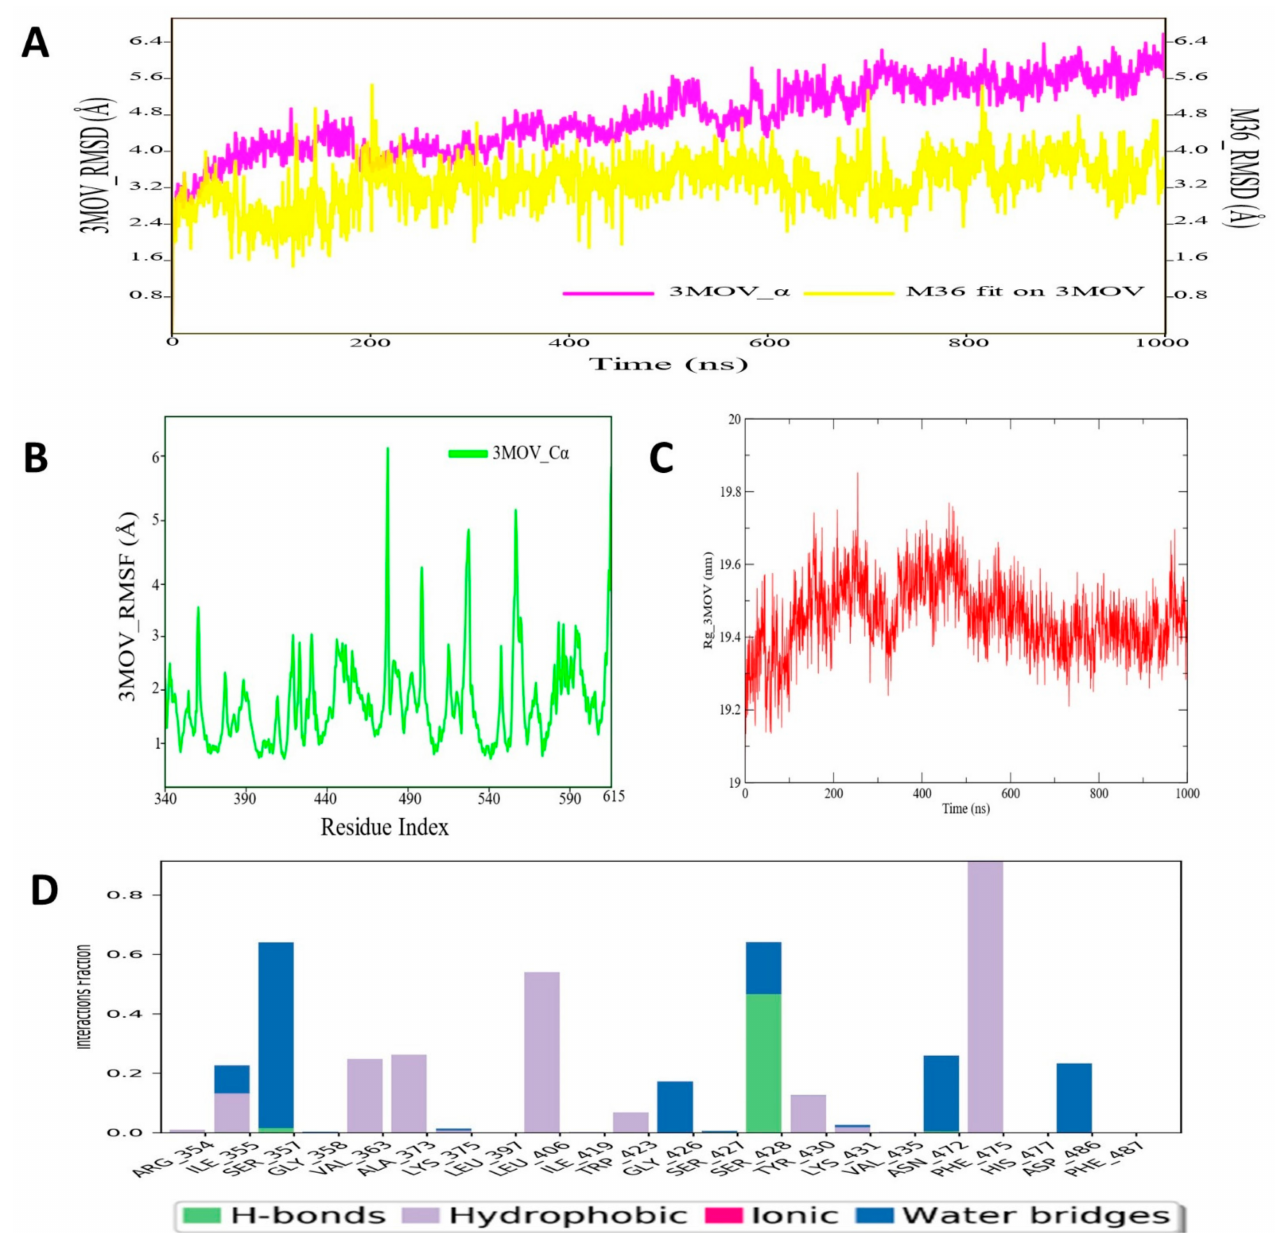
Figure 5. ( A ) RMSD profile of C-RAF (3OMV) protein backbone and compound M36 during 1000 ns simulation span; ( B ) RMSF profile of C-RAF (3OMV) protein backbone during 1000 ns simulation span; ( C ) RoG profile of C-CRAF protein backbone during 1000 ns simulation span; ( D ) illustration of the C-RAF (3OMV)–M36 contacts or interaction map monitored during 1000 ns simulation